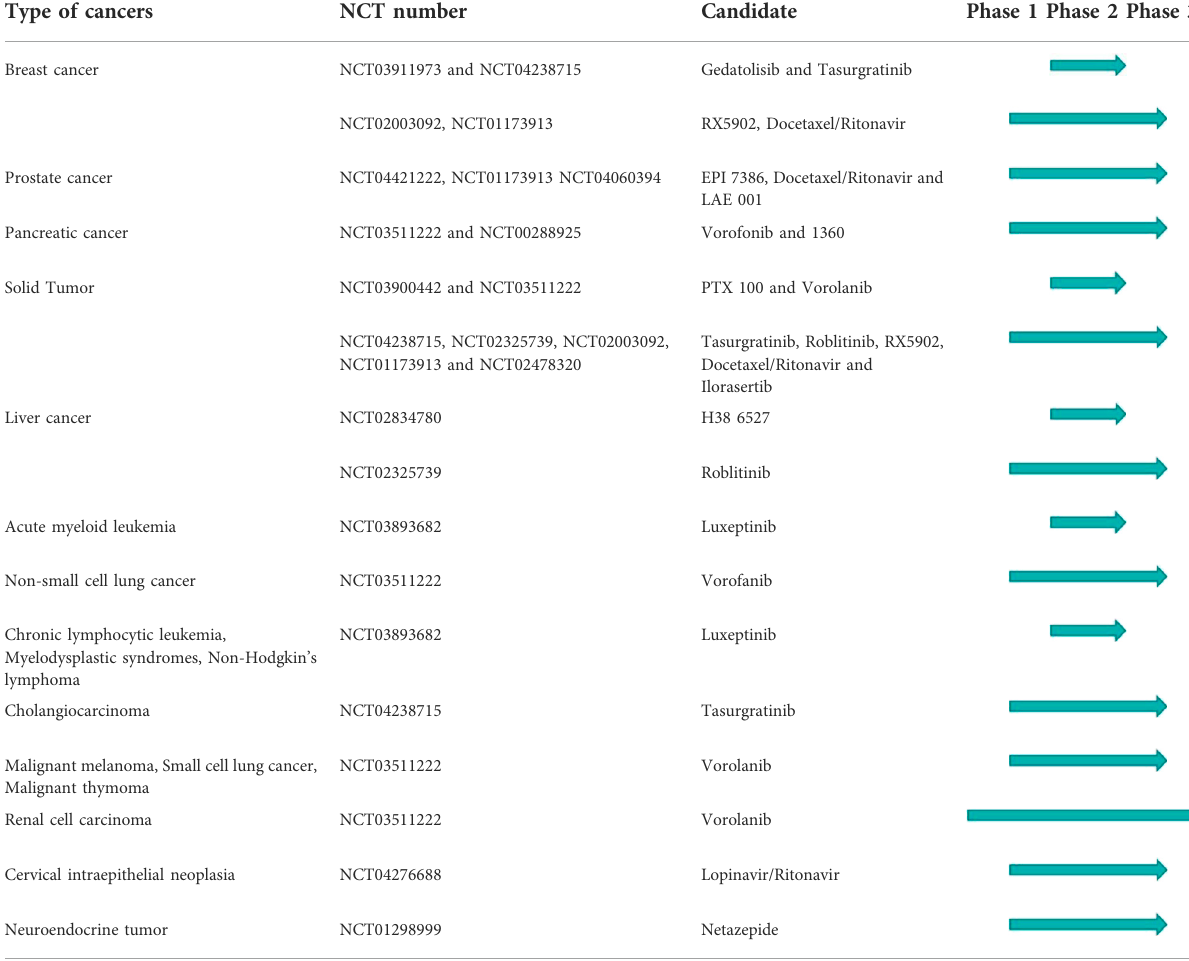
TABLE 2 Clinical trial progression and therapeutic indication for the new chemical entities. Type of